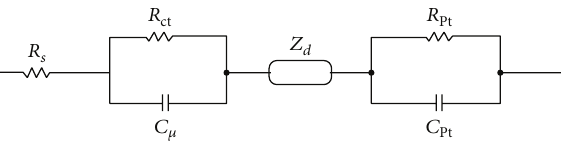
Figure 8: The simplified equivalent circuit of the DSCs fabri- cated by device structure of FTO glass substrate/SnO 2 /ZnO/dye/ electrolyte/lightly platinized FTO glass substrate. 𝑅 𝑠 is the series resistance which corresponds to the transport resistance of the and 𝐶 𝜇 are the charge transparent conduction oxide substrate. 𝑅 ct recombination resistance at the triple junctions and the chemical and 𝐶 are the charge transfer resis- capacitance, respectively. 𝑅 Pt Pt tance at the Pt/electrolyte interfaces and the interfacial capacitance, respectively, and 𝑍 𝑑 is the Nernst diffusion impedance of the redox species in the electrolyte